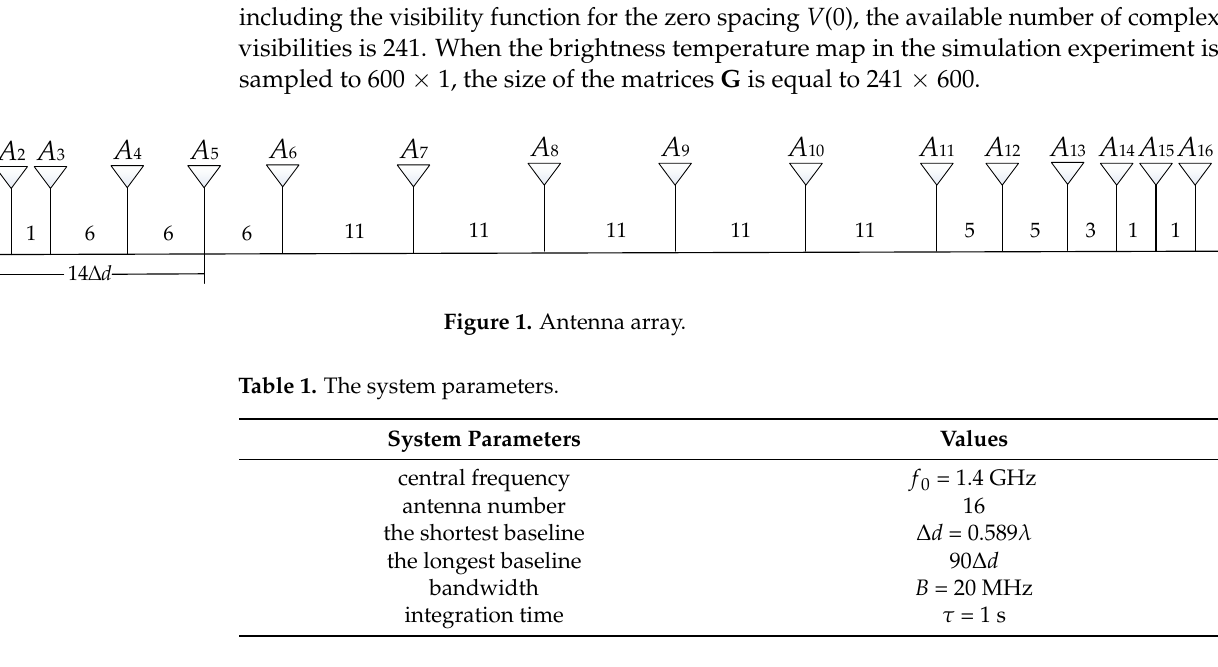
Figure 2. The original brightness temperature distribution of the ocean. When the measured visibility function samples are corrupted by white Gaussian noise with zero mean and variance σ 2 = 0.01 max ( V i ), the reconstructed results in the alias-free field of view are shown in Figure 3 via Tikhonov, band-limited and mul- ti-parameter regularization. In Figure 3, the horizontal axes ξ = sin θ is the direction co- sines in the Cartesian coordinates. For the convenience of comparison, the original dis- tribution in the alias-free field of view is also shown in Figure 3. The results show that the retrieved distributions by the TV, Tikhonov, and band-limited regularization have ob- vious oscillation ripples, particularly at the edge of the distributions. This is because SAIRs can only cover the limited bandwidth in the frequency domain, which will result